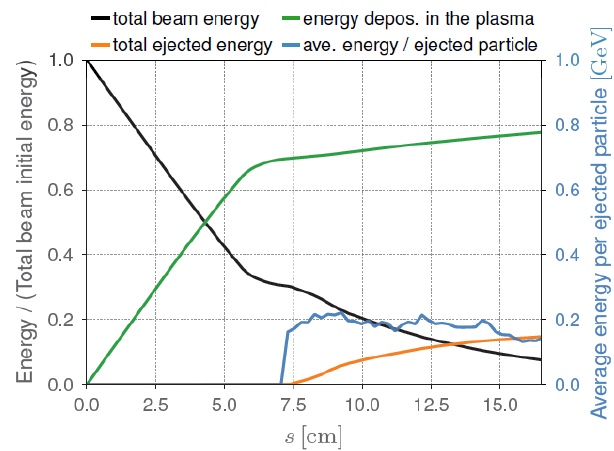
Figure 4. EuPRAXIA 1 GeV beam energy plots, as a function of propagation distance in plasma, for the density profile shown in Figure 2.